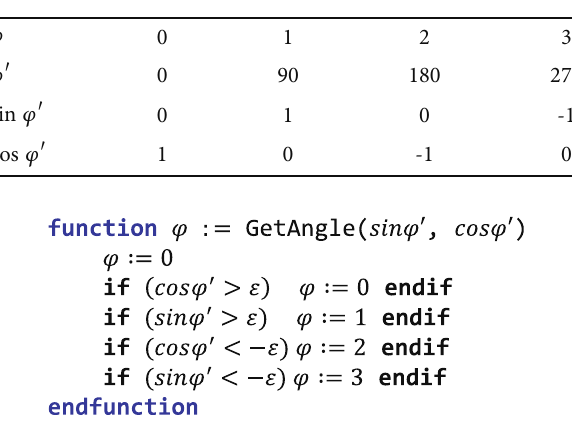
Figure 1: Function for the determination of rotation angle.